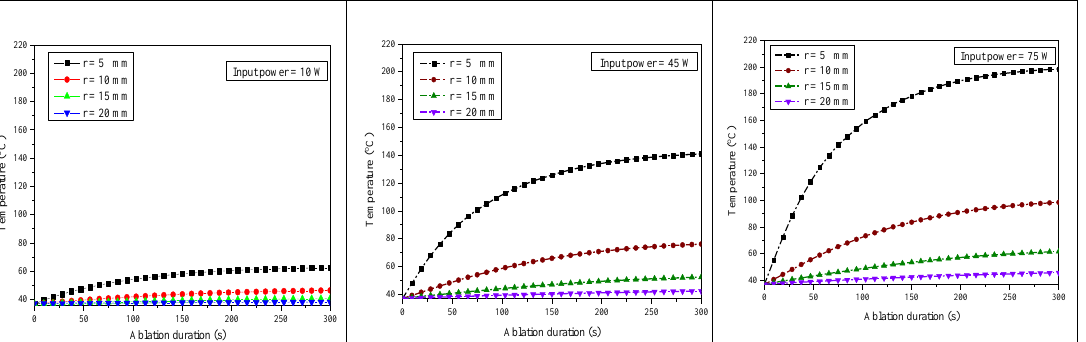
Figure 10. Temporal evolution of the temperature in four positions and for three values of input microwave power.